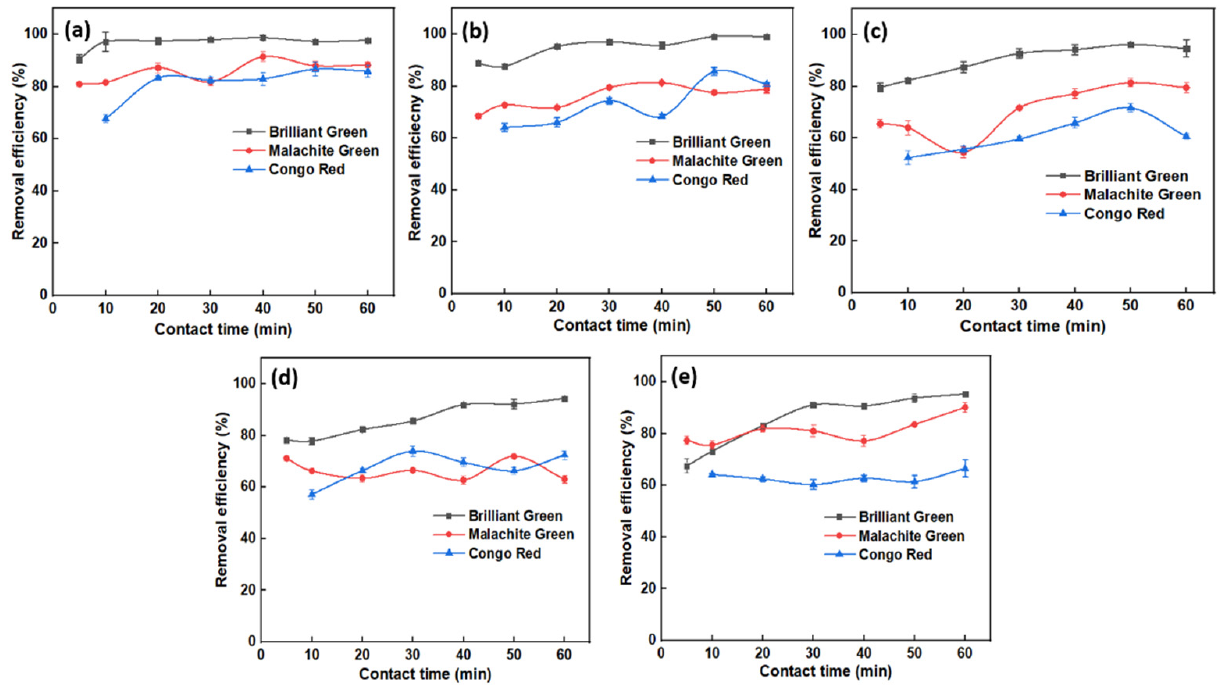
Figure 6. Effect on removal efficiency of OPL-derived CNSs when initial dye concentrations were ( a ) 10 µM, ( b ) 15 µM, ( c ) 20 µM, ( d ) 25 µM, and ( e ) 30 µM.